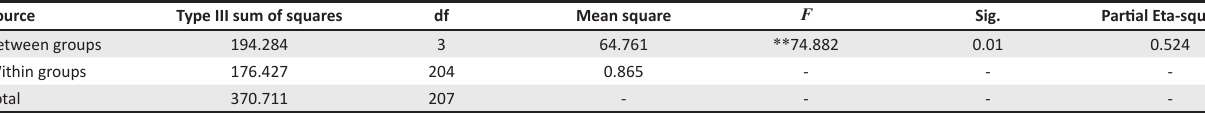
TABLE 1: Analysis of variance analysis (dependent variable = average